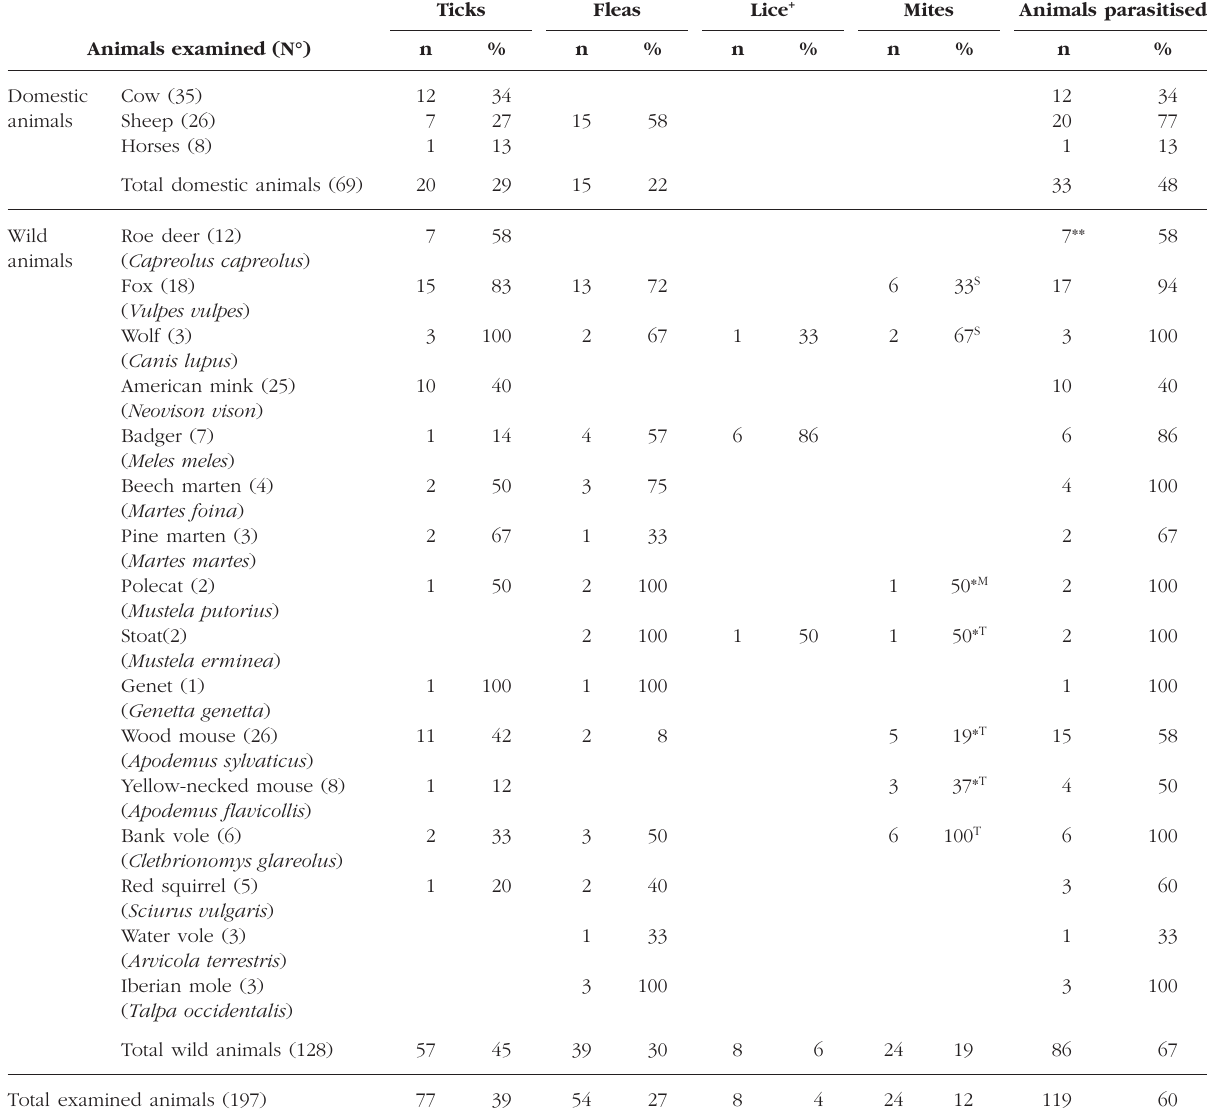
Table I. – Ectoparasitic arthropods in wild and domestic animals’